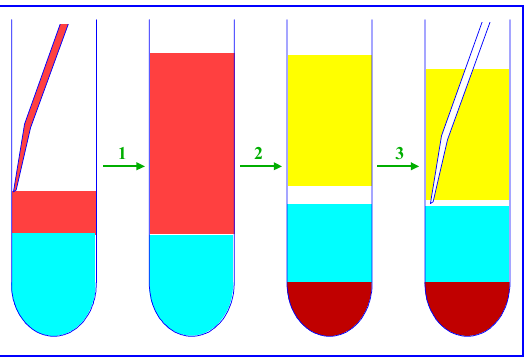
FIGURE 1 . Isolation of Macaque PBMCs on a density barrier. (1) 2 vol of blood layered over 1 vol of medium; (2-3) after centrifugation, the PBMC band is harvested by